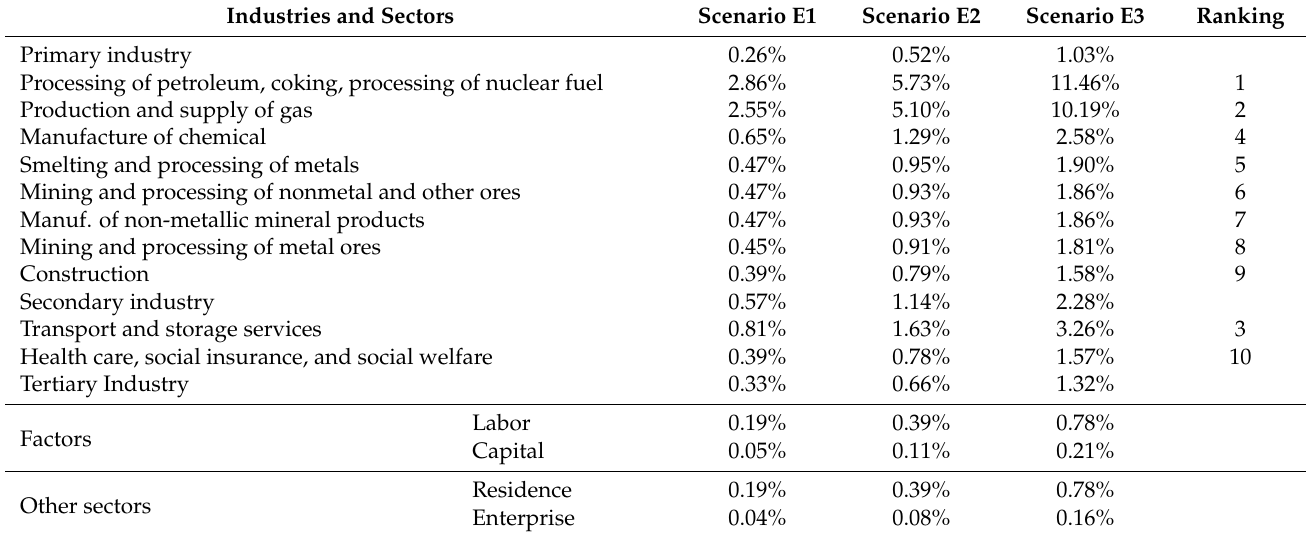
Table 9. Output and income changes of various industries and sectors based on raising oil and gas